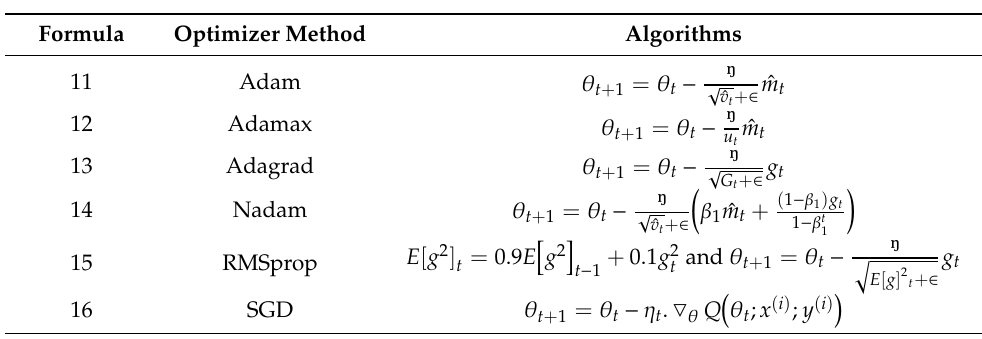
Table 2. The seven optimization algorithms to train parameters of the ResU-Net architecture for the wetland classification, adapted from [66,67,74–76].